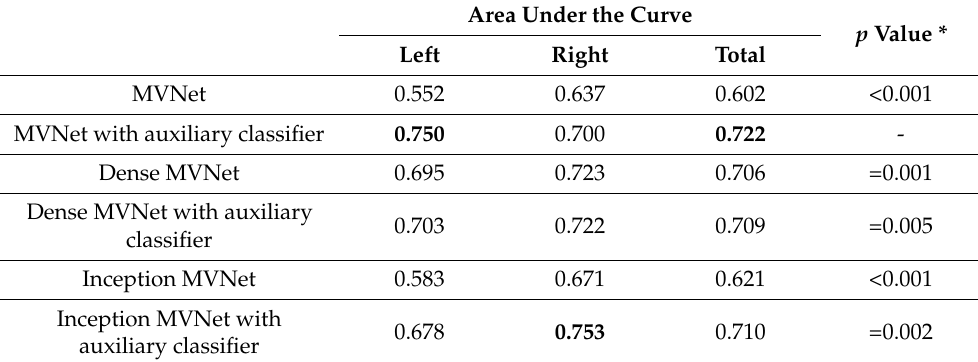
Table 2. Average AUC metrics for each model are provided, and p -values are computed by comparing the ROC of each model to the MVNet model with an auxiliary classifier, where we used the statistical significance level of 0.05. The networks with the best performance in each region of sinusitis are indicated in bold. Area Under the Curve p Value * Left Right Total MVNet 0.552 0.637 0.602 <0.001 MVNet with auxiliary classifier 0.750 0.700 0.722 - Dense MVNet 0.695 0.723 0.706 =0.001 Dense MVNet with auxiliary 0.703 0.722 0.709 =0.005 classifier <0.001 Inception MVNet with 0.678 0.710 auxiliary classifier